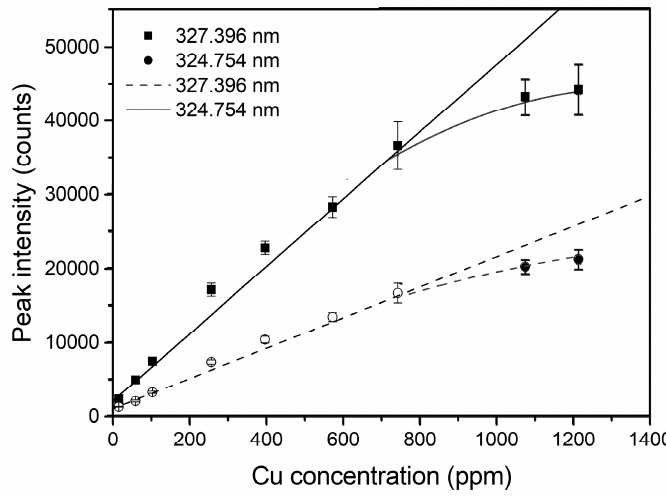
Figure 5. Scatterplots and curve-fitting results of reference Cu concentrations of Simiao rice versus the peak intensity of Cu I 324.754 nm and 327.396 nm. The reference concentration of Cu was obtained by FAAS.